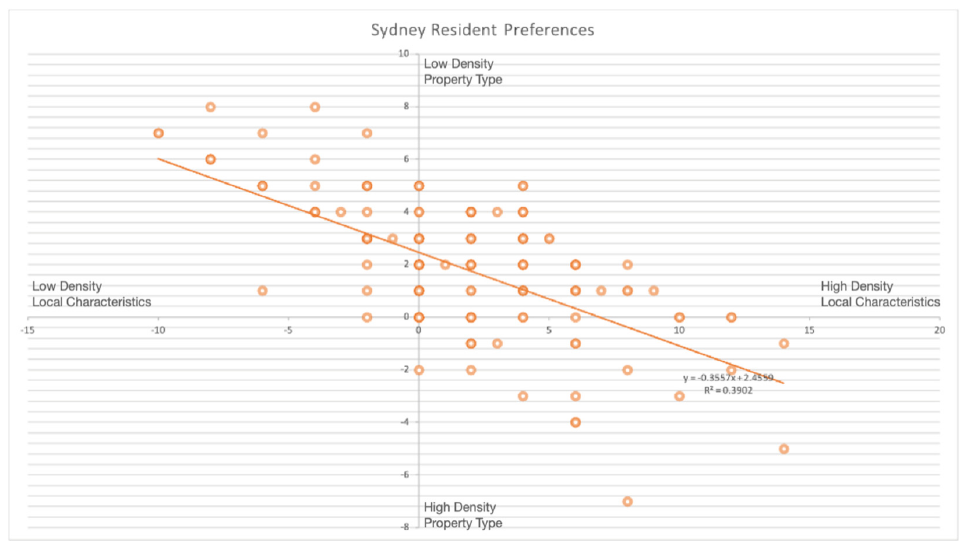
Figure 7. Graphed Regression Line. Figure 6. Graphed Regression